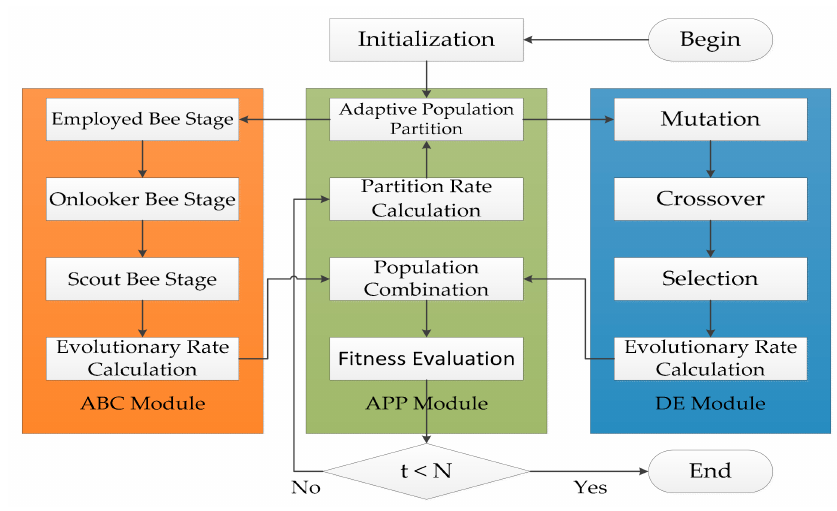
Figure 4. Block diagram of